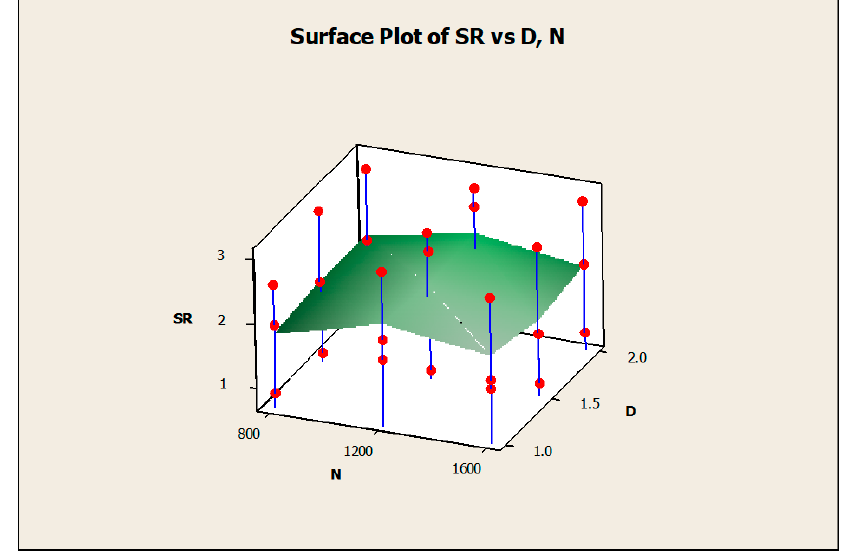
Figure 18. Surface diagram of SR with respect to N and D.